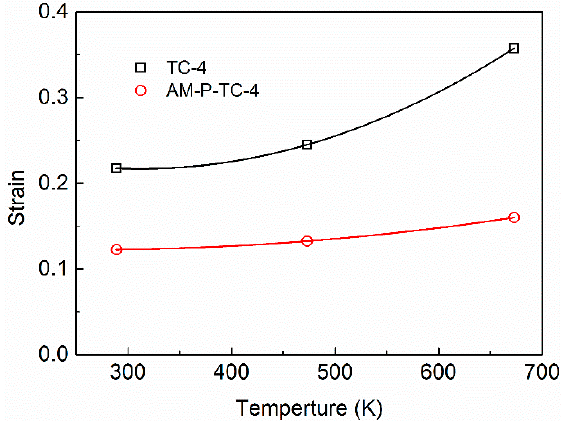
Figure 13. Effect of temperature on material fracture behavior.